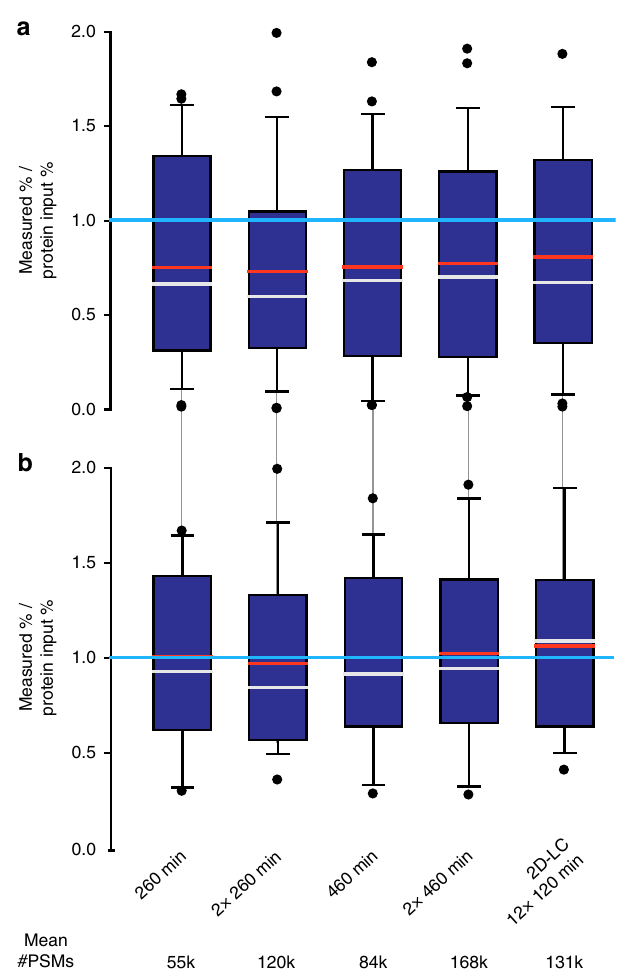
Fig. 5 Comparison of quanti fi cation accuracy for the UNEVEN mock community depending on LC method, gradient length and technical replication. Four biological replicates were run for each method and the number of peptide-spectrum matches (PSMs) was averaged per organism. The numbers below the plots give the average total number of PSMs generated for each of the methods. Box plots show the deviation of the amounts measured by summing of PSMs from the actual protein input amounts. The box indicates the 1st and 3rd quartile, the grey line indicates the median, the red line the average and the whiskers indicate the 10th and 90th percentile. If measurement and input were equal, then all values would be exactly 1 (indicated by bright blue line). The fi rst four methods were 1D-LC-MS/MS runs of the given length. The ‘ 2× ’ indicates if technical replicates were run. The fi fth method was 2D-LC-MS/MS runs with each of the 12 fractions measured for 120 min (detailed data for this Figure is in Supplementary Table 6). In a , the deviation values for all 27 detected strains and species are shown. In b , the deviation values are only shown for the 18 strains and species that had an abundance > 0.5% based on at